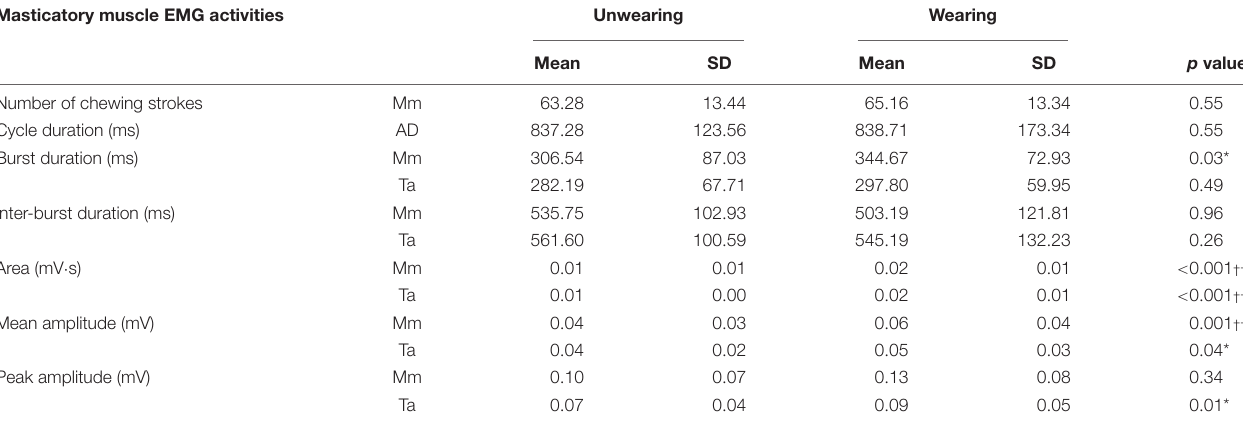
TABLE 3 | Masticatory muscle EMG activities under the Unwearing and Wearing